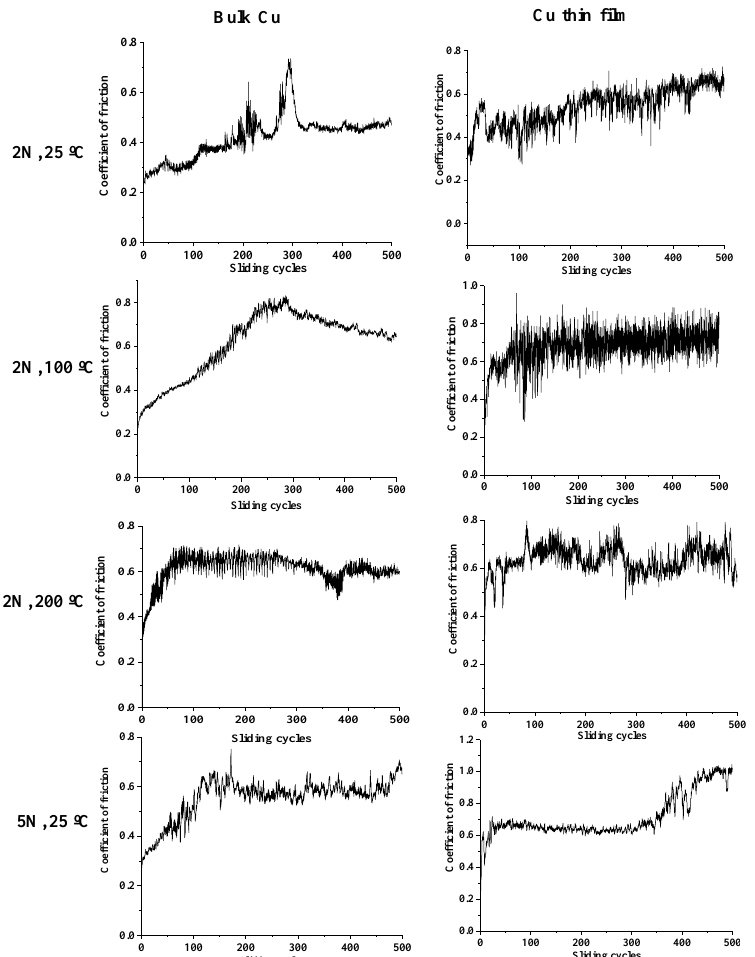
Figure 6. Coefficient of friction of bulk copper and Cu thin film at different loads and different Figure 6. Coe ffi cient of friction of bulk copper and Cu thin film at di ff erent loads and temperatures. di ff erent